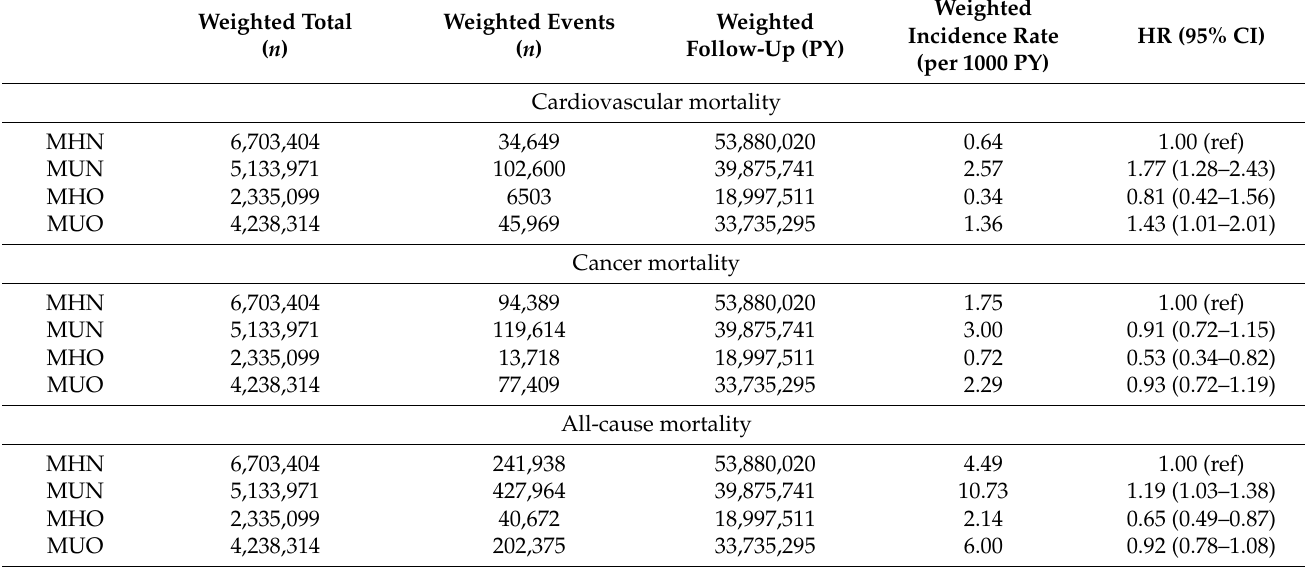
Table 2. Hazard ratios (HRs) and 95% confidence intervals (CIs) for mortality according to the combination of metabolic health risks and obesity status in